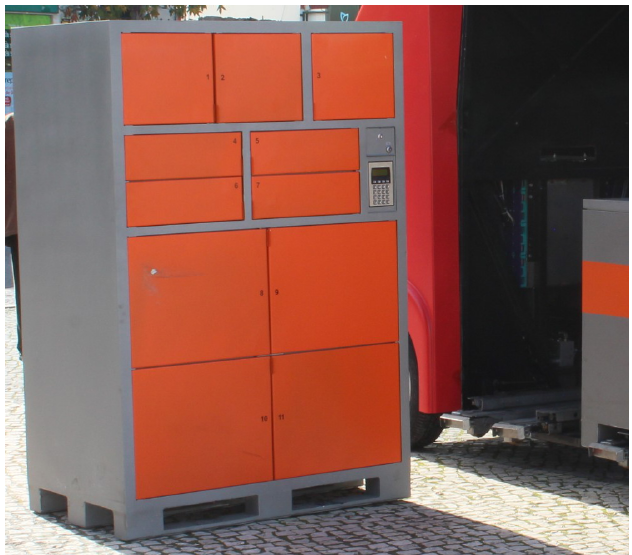
Figure 2. Loading of freight.